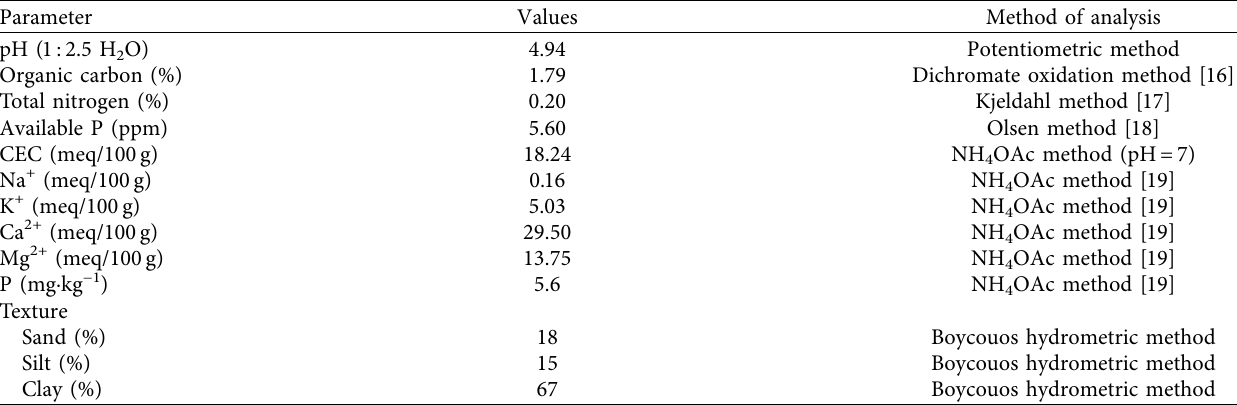
Table 1: Properties of soils in the study area.